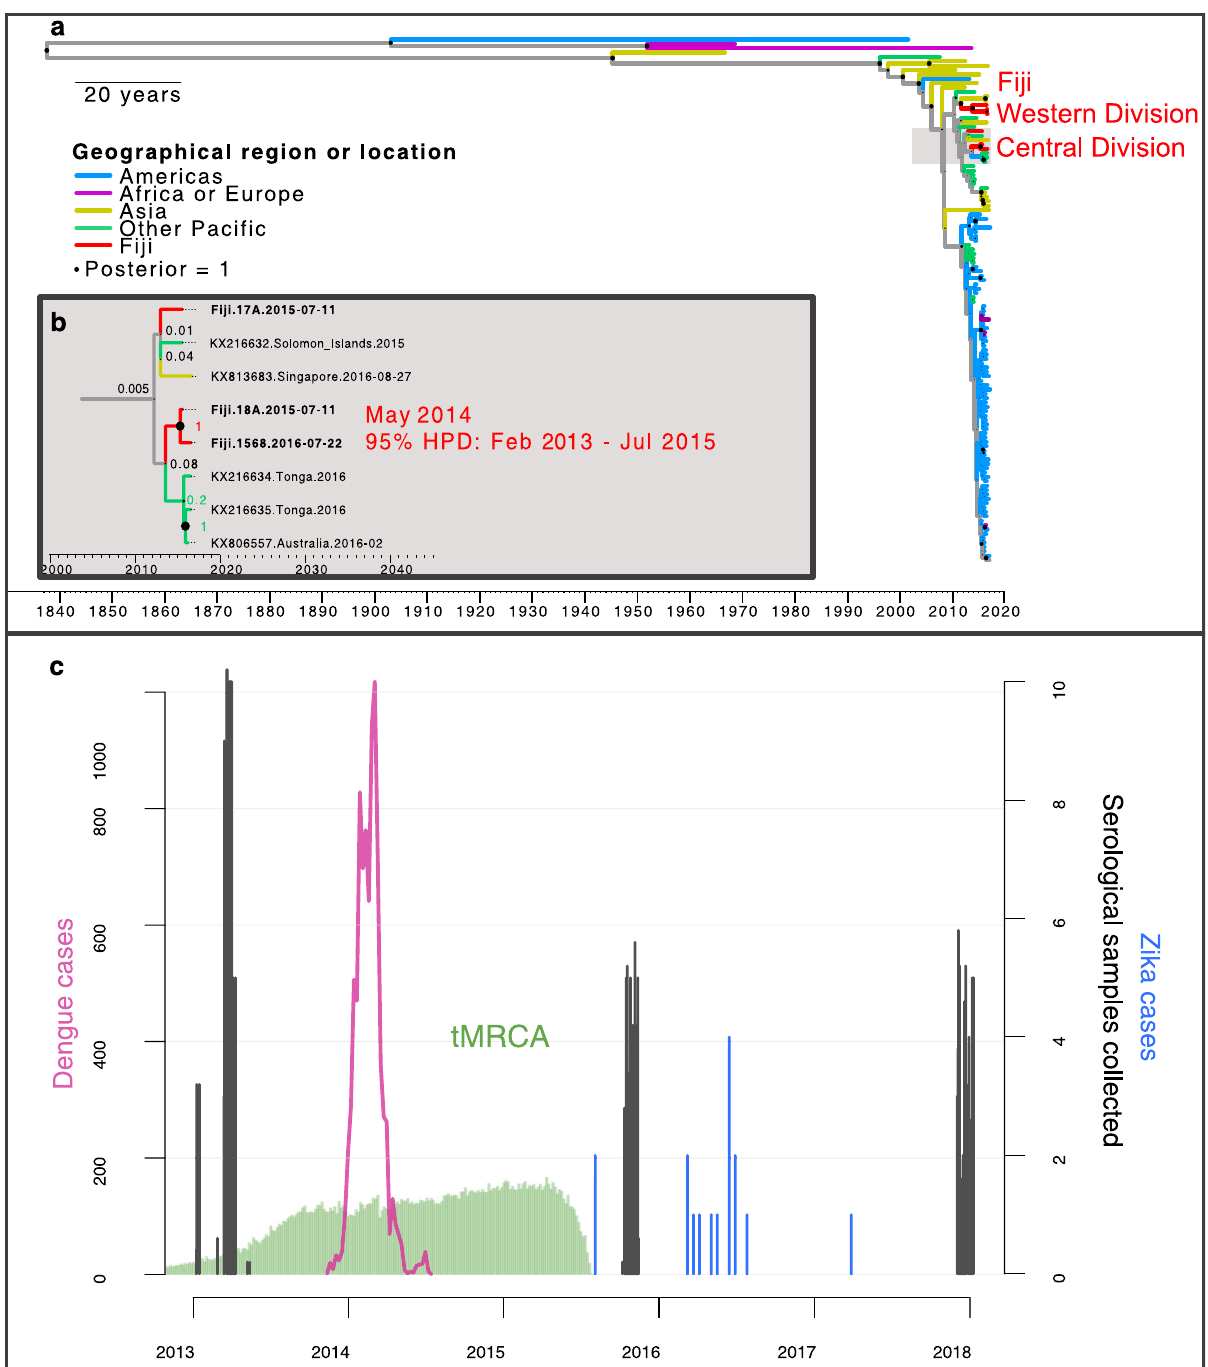
Fig. 1 Available data on ZIKV transmission in Fiji. a Dated Bayesian phylogeny of three sequences recovered from Central Division, Fiji, and other locations in the Paci fi c and Americas. Nodes with a posterior probability of 1.00 are indicated. Branch lengths correspond to time in calendar years. (inset b ) Detailed phylogeny of the Central Division cluster. The estimated time to most recent common ancestor (tMRCA) for the two closely related Central Division sequences, selected based on previous analysis 10 , is shown. c Green region, density of estimated tMRCA from phylogenetic analysis. This distribution was used as a prior for ZIKV introduction time in the main transmission model fi tting. Pink line, cases of DENV3. Blue bars, cases of ZIKV. Grey bars, serological samples collected in Central